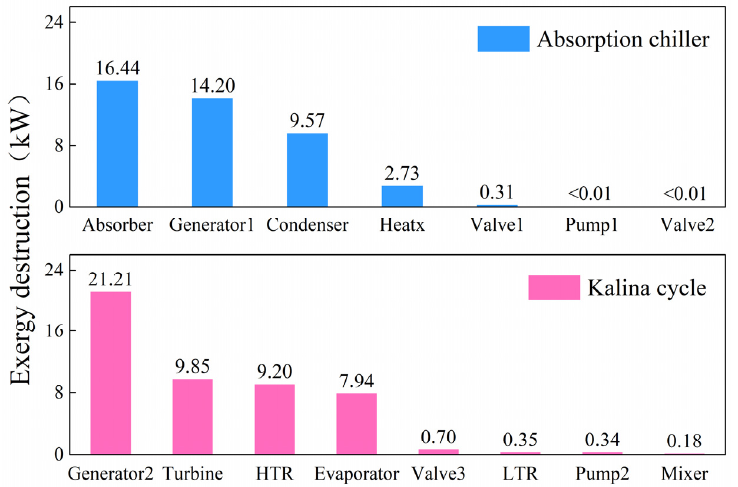
Figure 4. Exergy input, exergy destruction and electrical power output of the integrated system.